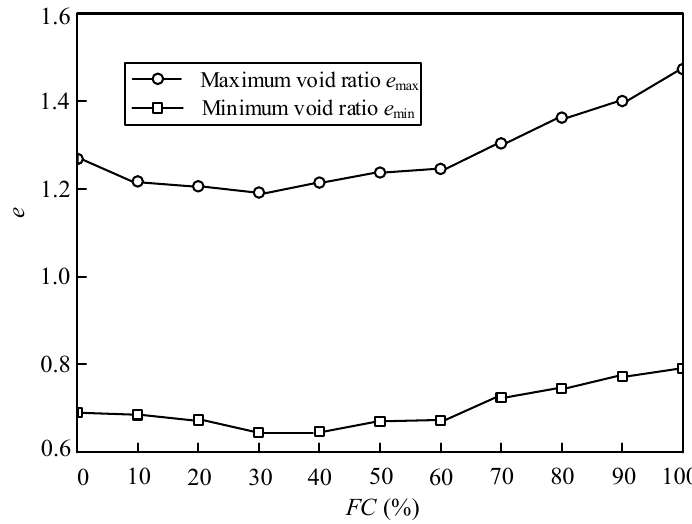
Figure 3. Variation of e min and e max versus FC of the sand-silt mixtures.